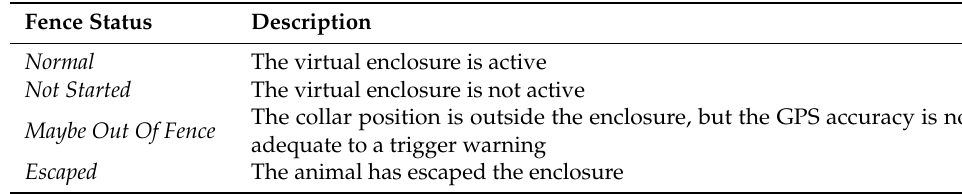
Table 2. Overview and description of the different fence